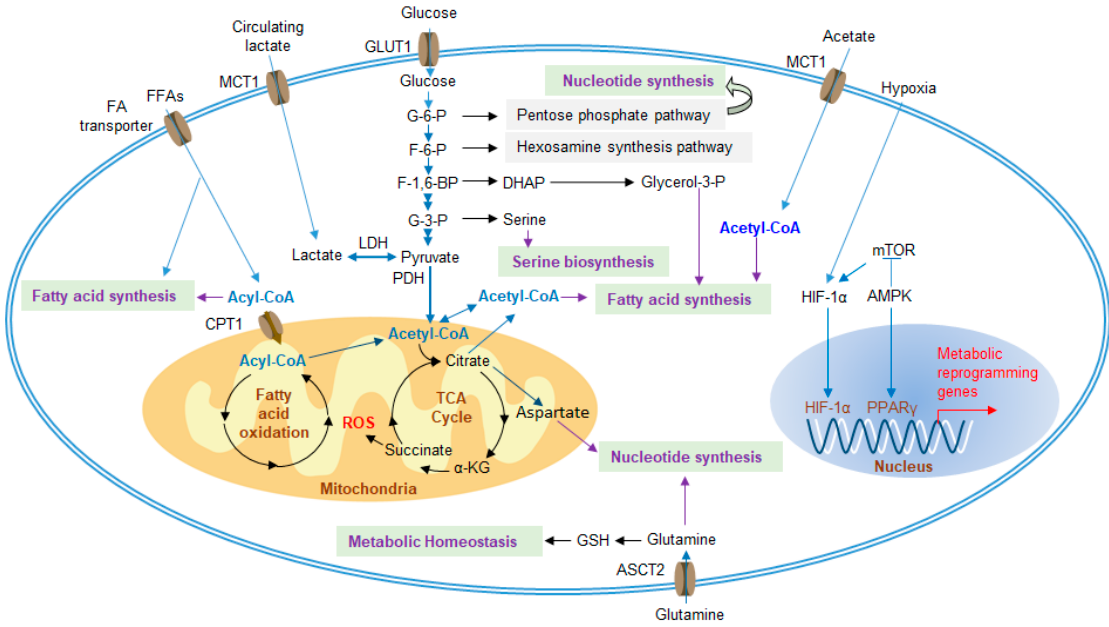
Figure 3. Metabolic regulatory pathways of MDSCs in the TME. Under hypoxic conditions, metabolic genes are upregulated, and increased metabolism enhances the suppressive function of MDSCs. MDSCs increase the uptake of extracellular nutrients, such as glucose, FA, glutamine and acetate, which are required for glycolysis, the TCA cycle, FAO, fatty acid synthesis and amino acid synthesis. Furthermore, excessive lactate, generated by tumor cells, can also be transported into MDSCs to participate in metabolism. FA, fatty acid; TCA cycle, tricarboxylic acid cycle; FAO, fatty acid oxidation; FFAs, free fatty acids; MCT1, monocarboxylate transporter 1; GLUT1, glucose transporter 1; G-6-P,